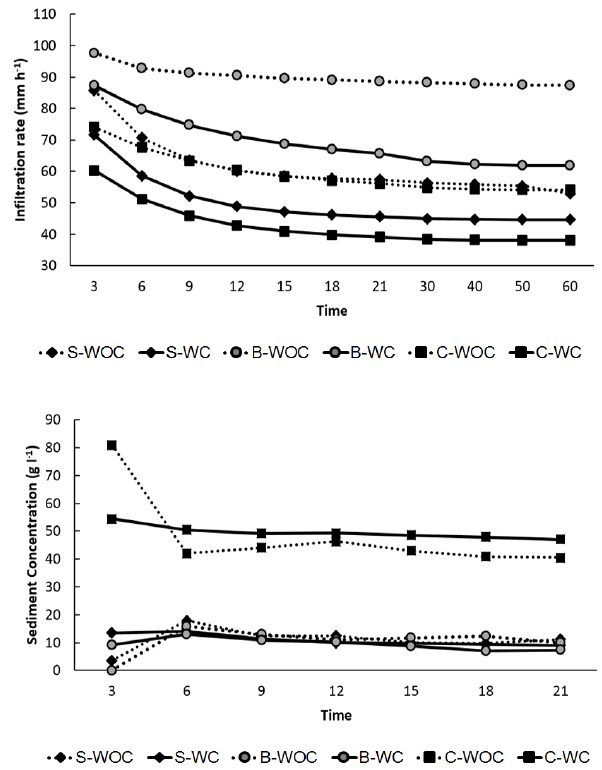
Figure 3. Temporal evolution of infiltration rate (by Horton) (a) and sediment concentration (b)